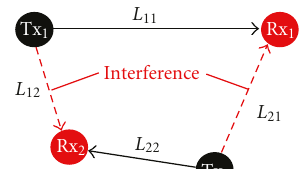
Figure 1: 2-link wireless network. Solid and dashed arrows indicate intended communication links and interference,